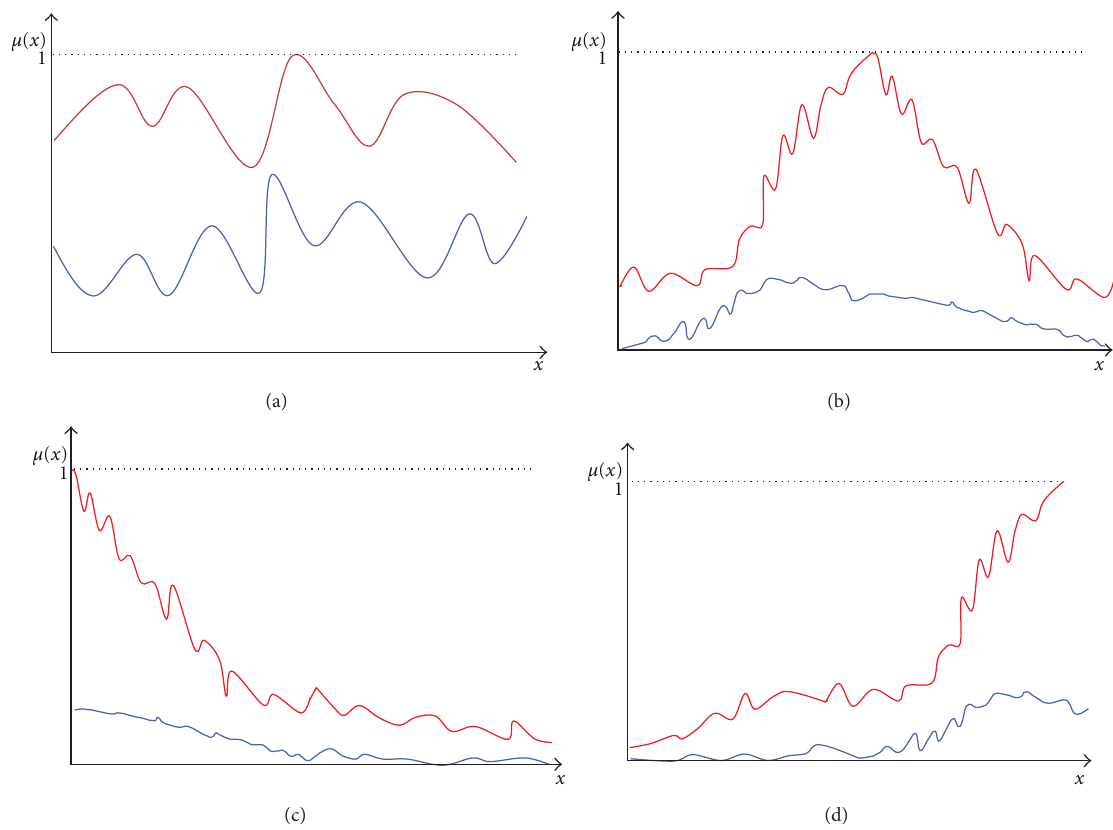
Figure 2: FOUs cases used in the experiments. (a) Uniform random FOU. (b) Centered uniform random FOU. (c) Right-sided uniform random FOU. (d) Left-sided uniform random